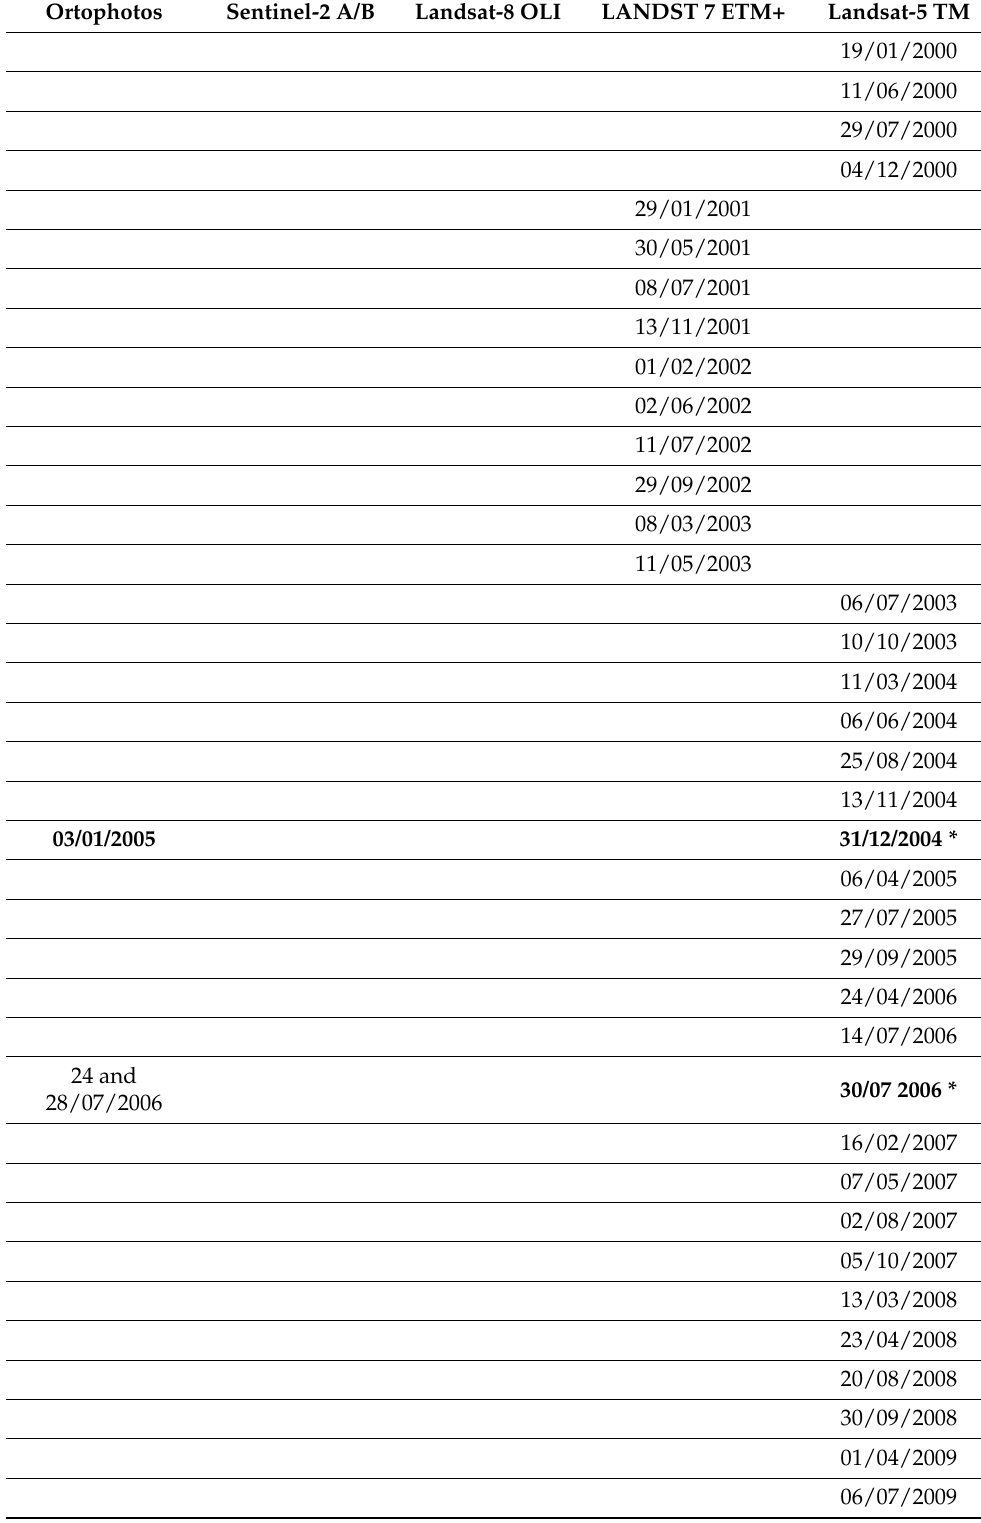
Table A1. List of images used in the study by date. * images validated with